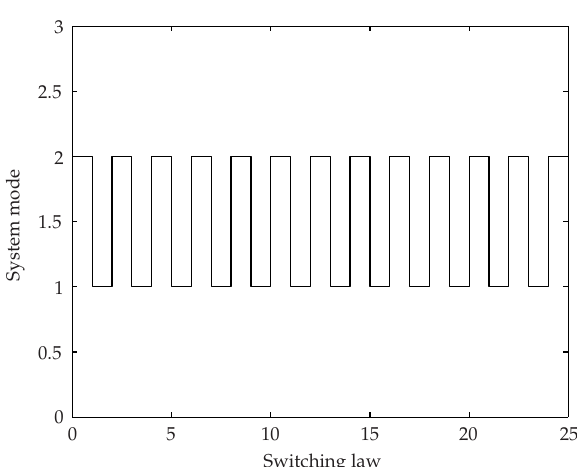
Figure 1: The switching signal of the switched systems.